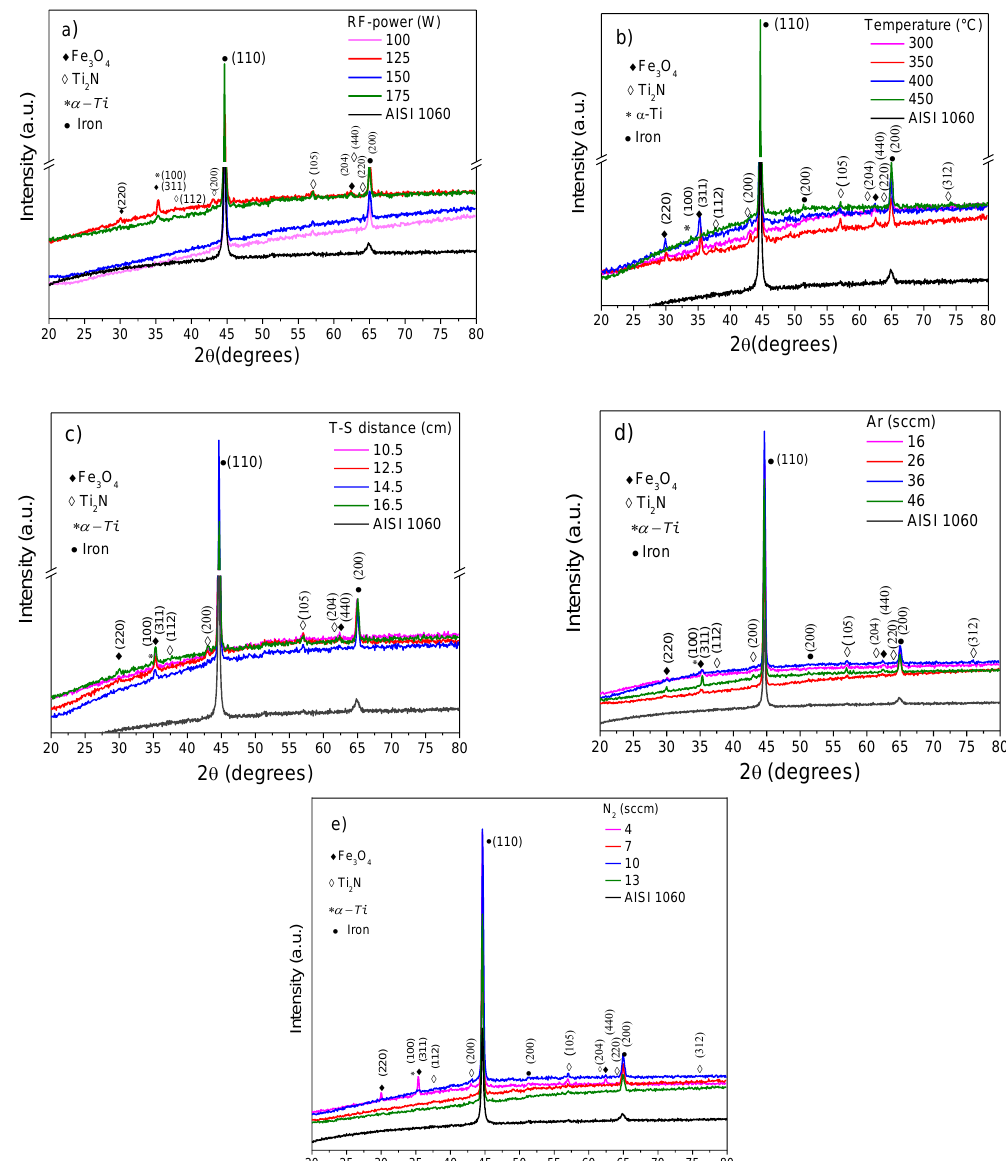
Figure 1. XDR pattern of Ti/Ti 2 N films using five sets of parameters, and the parameter that varied was: ( a ) RF-power, ( b ) temperature on substrate, ( c ) distance target-substrate, ( d ) flow Ar gas, and ( e ) mass flow of N 2 .